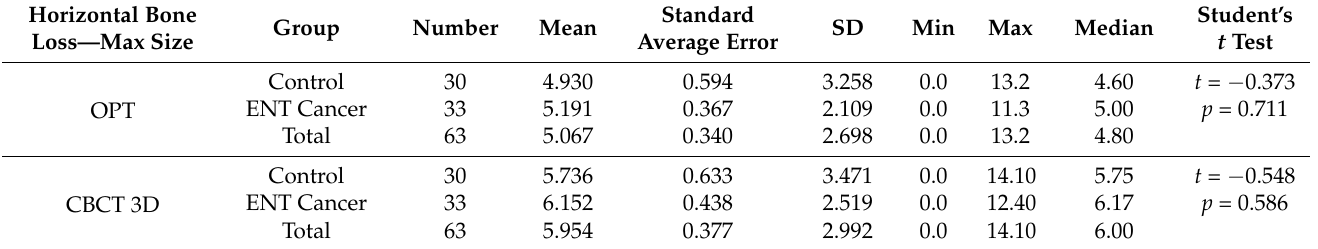
Table 2. Horizontal bone loss: comparative descriptive statistics in the control/ENT cancer group.